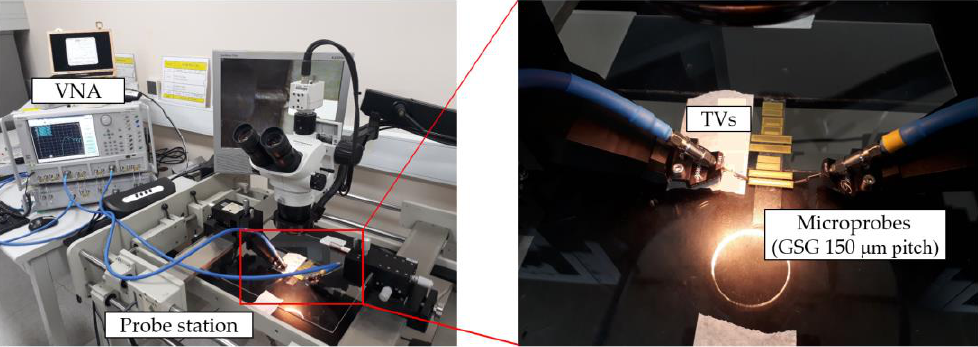
Figure 6. Measurement setup for S-parameters with a vector network analyzer and microprobes.